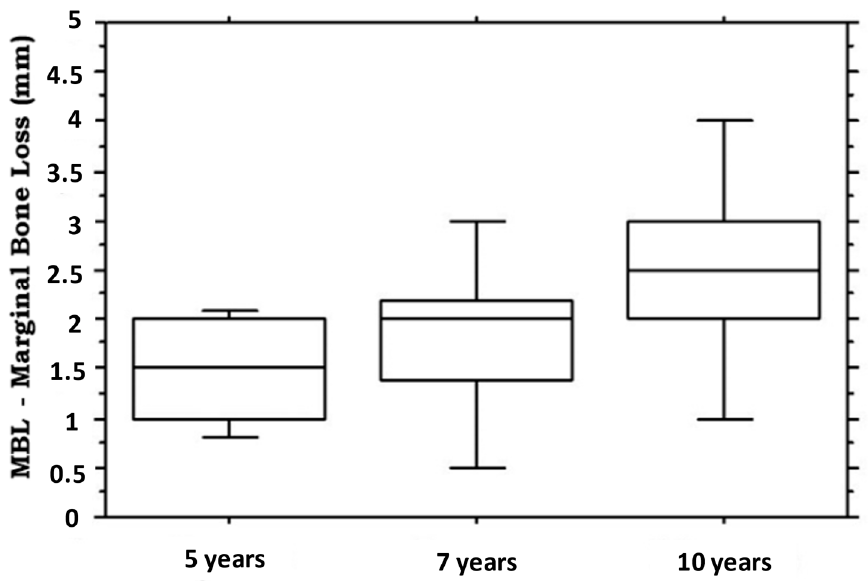
Figure 2. Boxplot illustrating the marginal bone loss measured in millimeters at 5-, 7- and 10-years of follow-up. The median is the horizontal black line inside the box. Table 3. Risk indicators for marginal bone loss > 3.0 mm (OR stands for Odds Ratio, while CI stands for Confidence Interval, p < 0.05 was considered statistically significant, we replicate the test for significant results “a”).